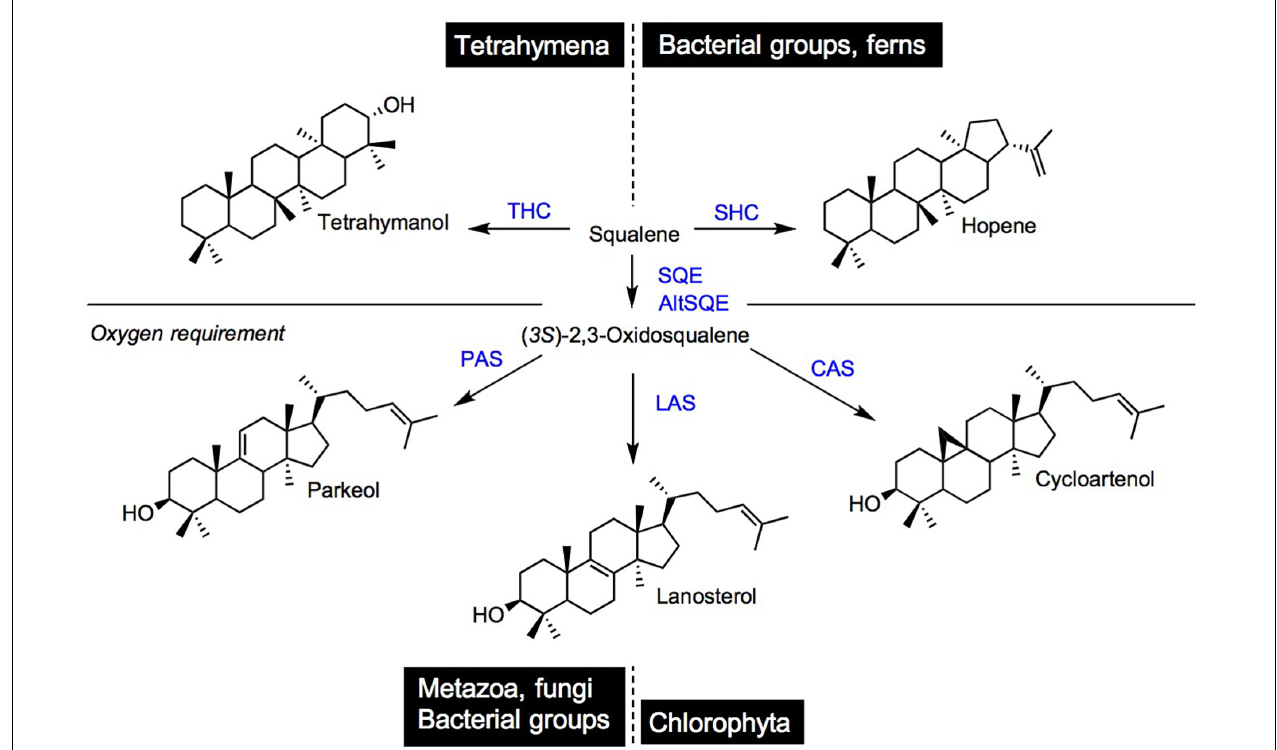
FIGURE 5 | Cyclization products of squalene and (3 S )-2,3-oxidosqualene in species and taxonomic groups. THC, tetrahymanol synthase; SHC, squalene hopene cyclase; SQE, squalene epoxidase; AltSQE, alternative squalene epoxidase; PAS, parkeol synthase; LAS, lanosterol cyclase; and CAS, cycloartenol